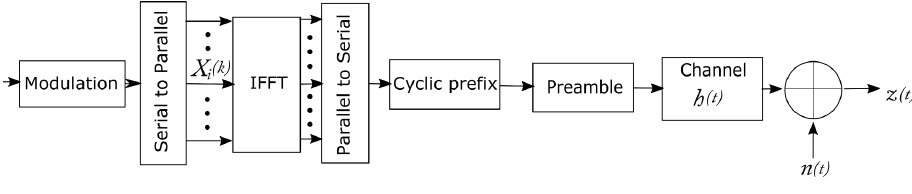
Figure 1. Block diagram of the OFDM transmitter.